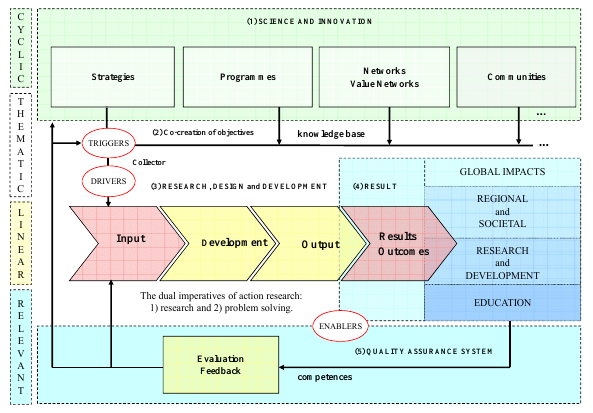
Figure 5. Learning with the R&D